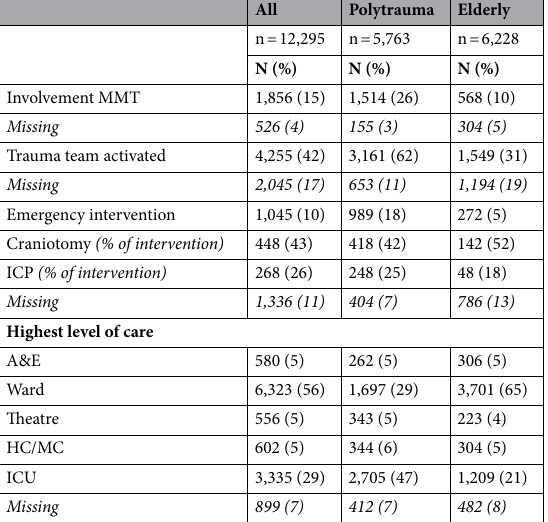
Table 2. Treatment variables. MMT = Mobile Medical Team, ICP = Intracranial pressure meter, A& = Accident and Emergency department, HC = High Care unit, MC = Medium Care unit, ICU = Intensive Care Unit.